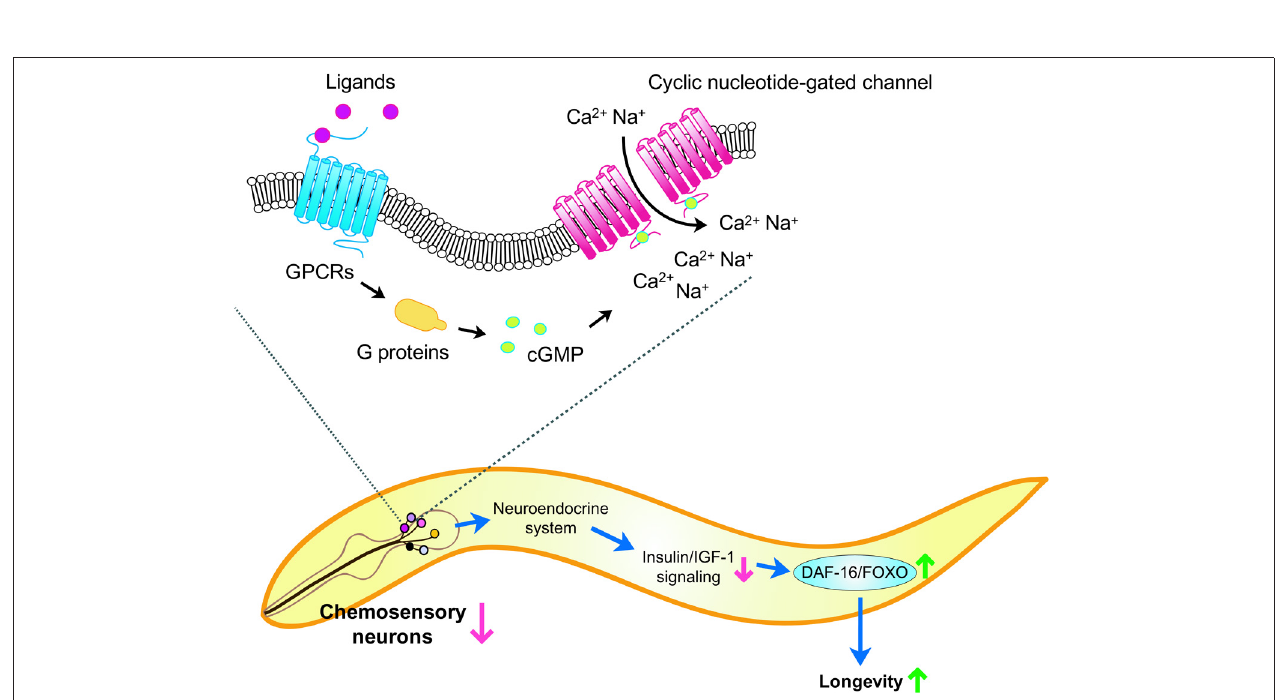
FIGURE 1 | C. elegans and D. melanogaster sensory systems influence lifespan. (A) C. elegans chemosensory and thermosensory systems regulate lifespan through hormonal signaling. Specific chemosensory (olfactory or gustatory) neurons promote or limit longevity. Insulin/IGF-1 signaling can mediate this longevity response downstream of chemosensory neurons. Perturbation of thermosensory system accelerates aging at high temperatures by influencing the sterol hormonal